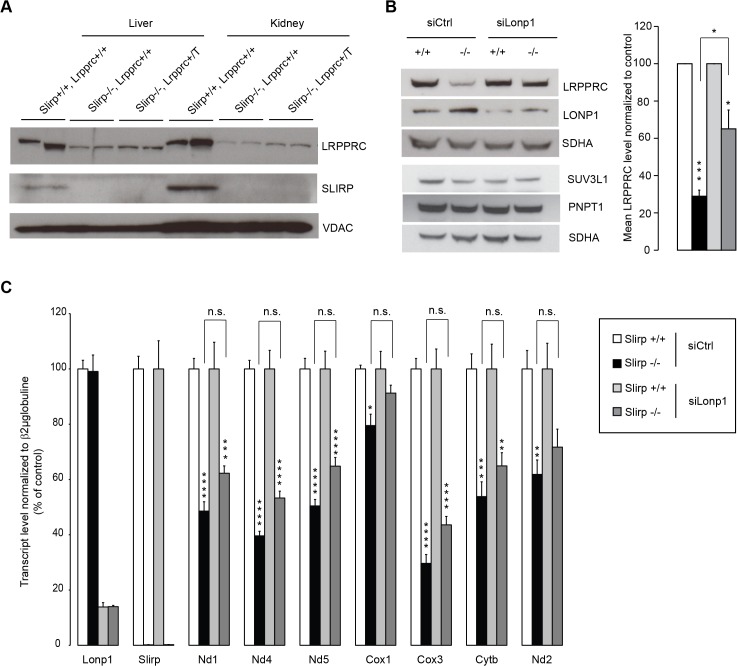
LRPPRC is degraded by LONP1 in the absence of SLIRP and LRPPRC alone cannot preserve mitochondrial transcript stability.(A) Immunoblotting of SLIRP and LRPPRC protein levels in liver and kidney mitochondria from 12-week old wild-type (Slirp
+/+, Lrpprc
+/+) and Slirp homozygous knockout (Slirp
-/-, Lrpprc
+/+) mice and mice overexpressing Lrpprc on a Slirp homozygous knockout background (Slirp-/-, Lrpprc+/T). VDAC was used as a loading control. (B) Immunoblotting of LRPPRC protein levels in Slirp
+/+ and Slirp
-/- primary MEFs after transfection with a siRNA directed against the expression of the LONP1 protease (siLonp1) or with a scrambled siRNA (siCtrl). LONP1 was detected to assess the efficiency of the knockdown (KD), SUV3L1 and PNPT1 were detected to assess the steady-state level of the mitochondrial RNA degradosome and SDHA was used as a loading control (left panel). The right panel represents the quantification of three independent experiments. Error bars represent SEM. * p value < 0.05. *** p value < 0.001. (C) QRT-PCR analysis of the mitochondrial transcript steady-state levels after KD of Lonp1 expression in Slirp
+/+ and Slirp
-/- MEFs as described in (B). n = 6. Error bars represent SEM. * p value < 0.05. ** p value < 0.01. *** p value < 0.001. n.s. means not significant.